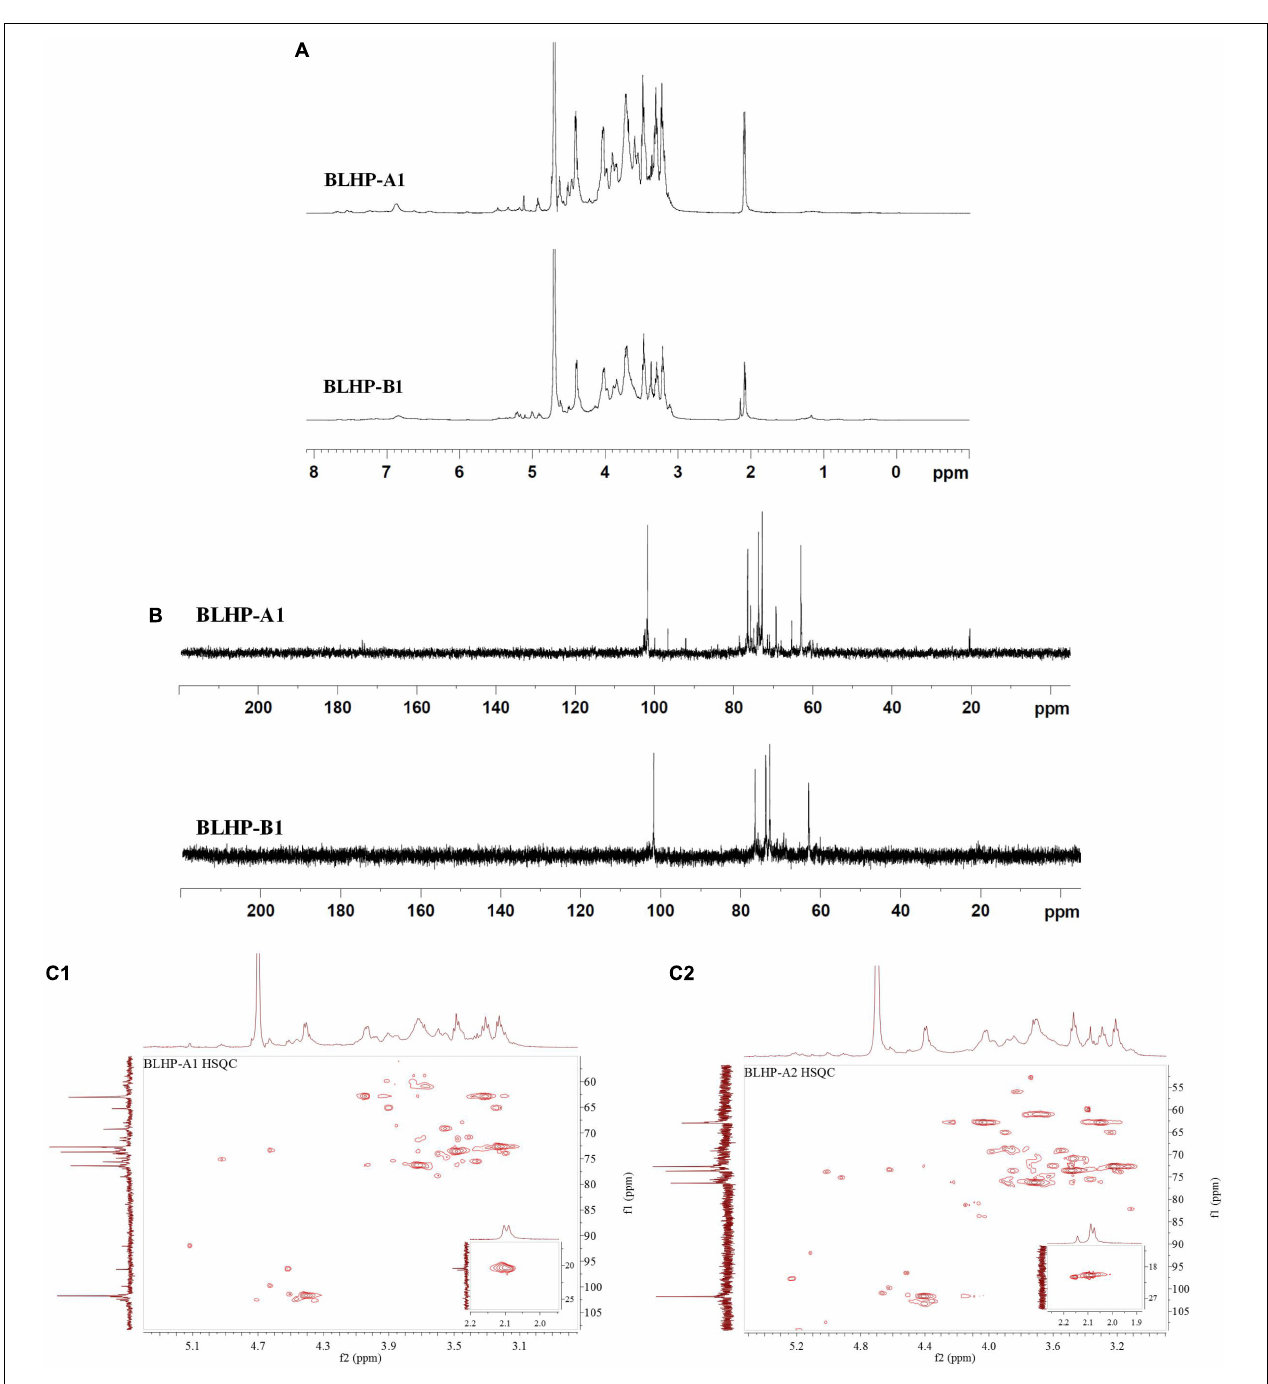
FIGURE 5 | 1 H (A) and 13 C (B) NMR spectra and HSQC for BLHP-A1 and BLHP-B1 samples (C1,C2) after deduction of some weak